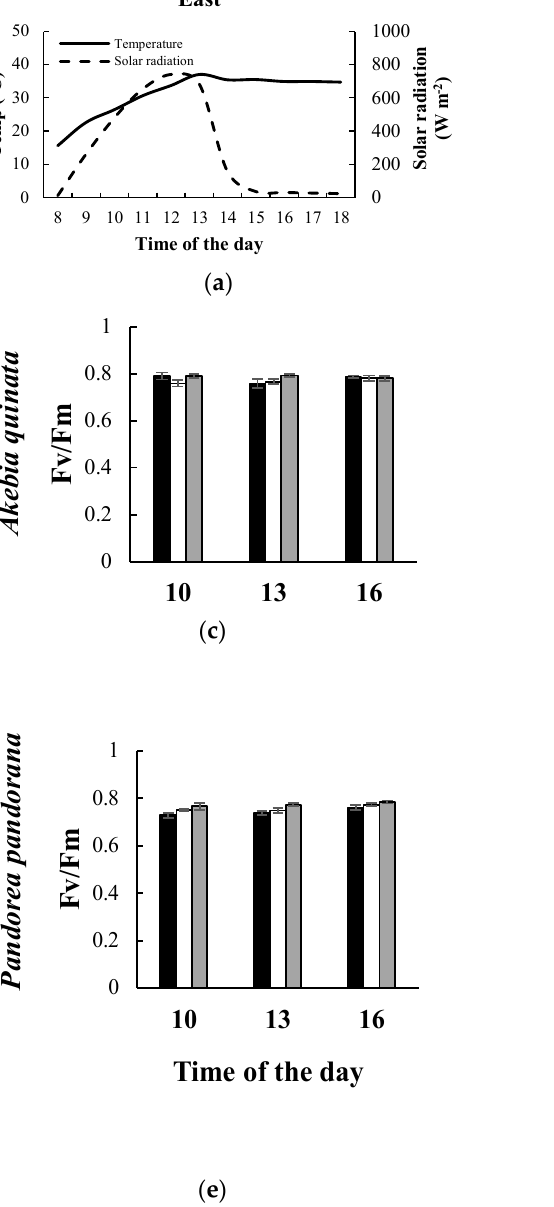
( b ) Figure 4. Average total leaf area ( a ) and average specific leaf area (SLA) ( b ) of Akebia quinata and Pandorea pandorana grown in three different rooting volumes after six months of growth. Values are means ± SE. Different letters represent significant differences within species, p < 0.001; lowercase, Akebia quinata ; capital, Pandorea pandorana . 3.2. Effects of Air Temperature and Solar Radiation on the Fv/Fm Ratio of Climbing Plants On a hot sunny day, on the west ‐ facing aspect, the air temperature peaked at approx ‐